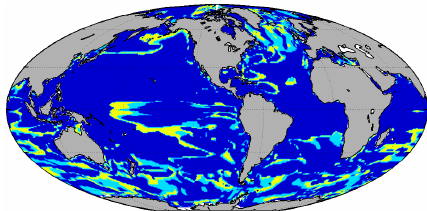
Figure 8. Areas of trophic amplification (dark blue) attenuation (light blue) and changes of opposite sign for NPP and MESOZP (yellow) in Fig. 3. Note that areas of trophic attenuation and changes of opposite sign often correspond to either (a) transition regions/fringes between areas increasing and decreasing NPP, or (b) areas with dynamic changes in ZPC that counteract the amplify- ing effects of ZGE and MESOTL (e.g., the subpolar North Atlantic and parts of the Southern